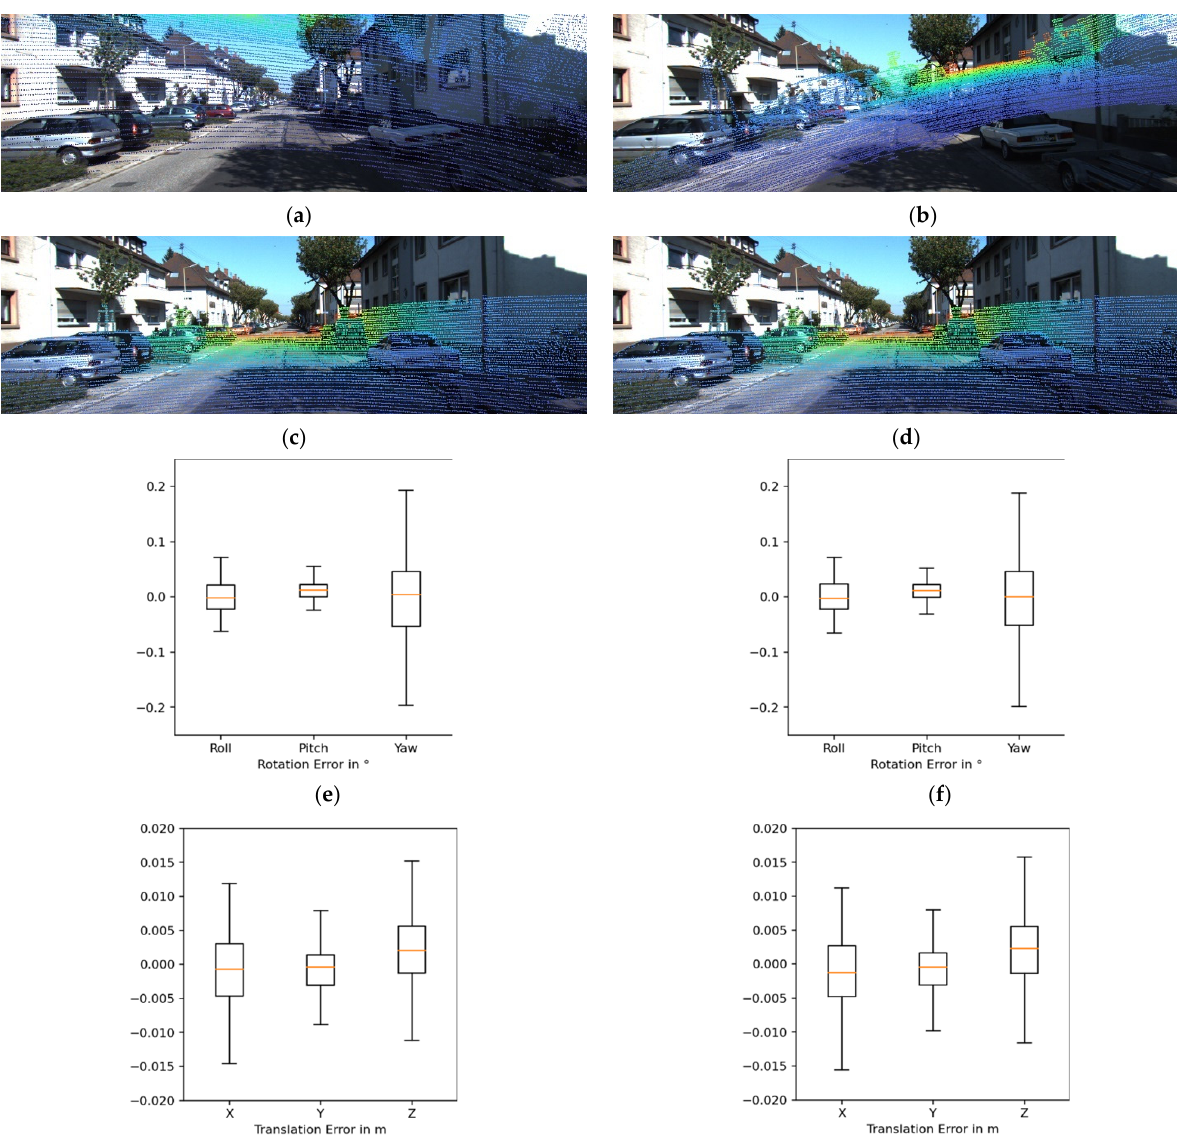
Table 2. Comparison of calibration performance between our method and other CNN-based meth- ods.